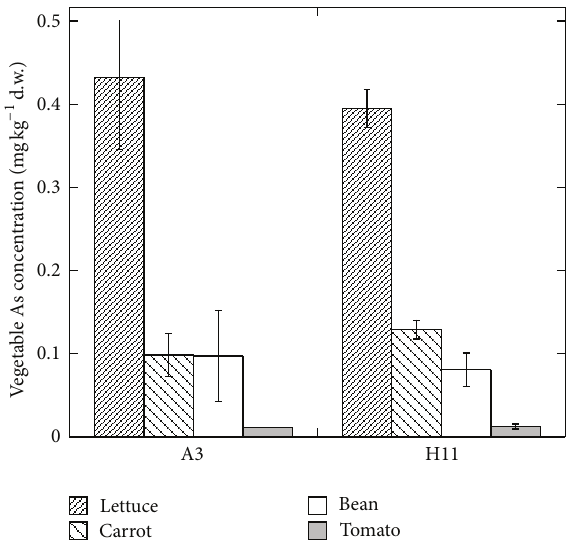
Figure 7: As concentrations (mgkg −1 d.w.) in lettuce, carrot, bean, and tomato grown on orchard soils with similar total As but pH of 6.2 (A3) and 4.9